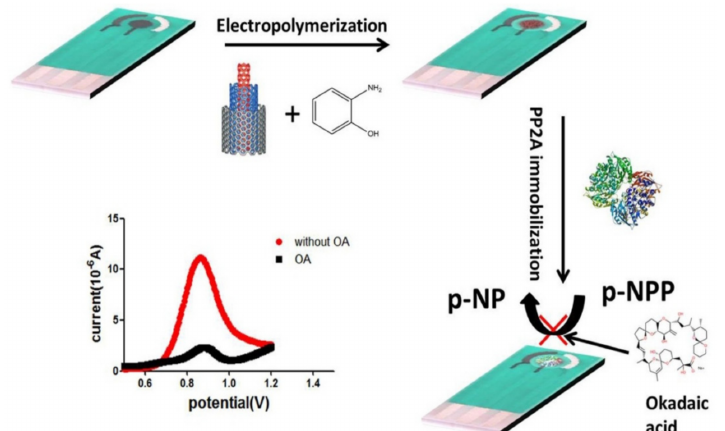
Figure 10. Poly-o-aminophenol (PoAP)-CNTs electrode for the development of an